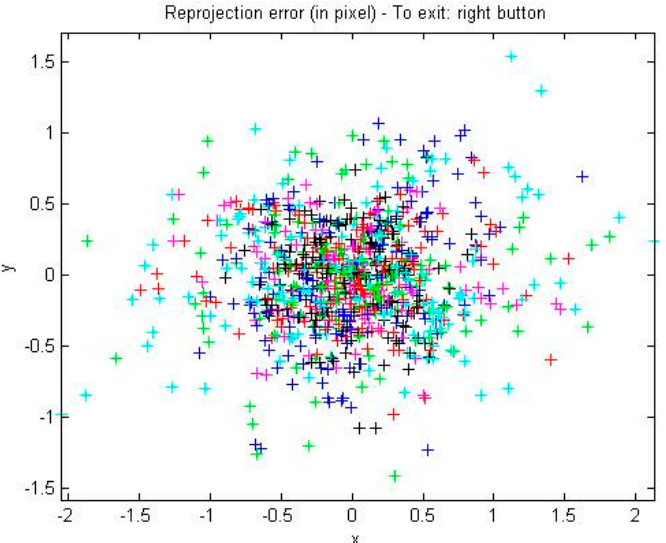
Figure 7. Error distribution diagram of corners.